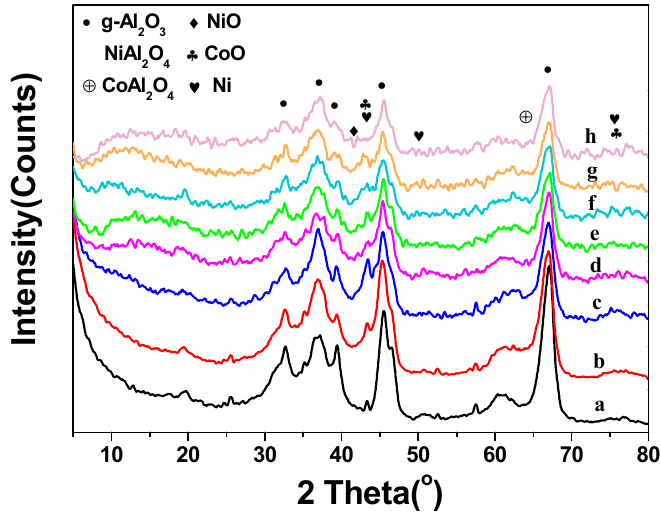
Figure 2. XRD patterns of ( a ) γ -Al 2 O 3 , ( b ) Ni/ γ -Al 2 O 3 , ( c ) Ni-3Co/ γ -Al 2 O 3 , ( d ) Ni-1.5Co/ γ -Al 2 O 3 , ( e ) Ni-1Co/ γ -Al 2 O 3 , ( f ) Ni-0.67Co/ γ -Al 2 O 3 , ( g ) Ni-0.33Co/ γ -Al 2 O 3 and ( h ) Co/ γ -Al 2 O 3.